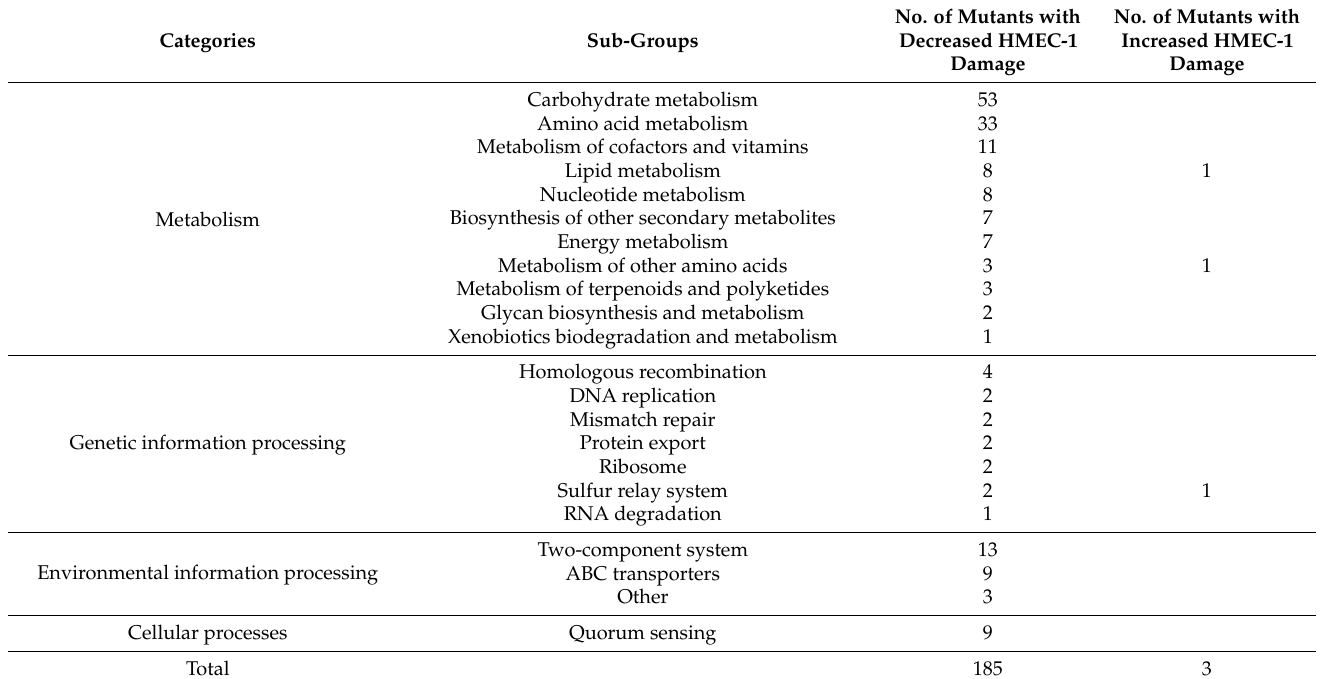
Table 4. Numbers of genes from different KEGG pathway